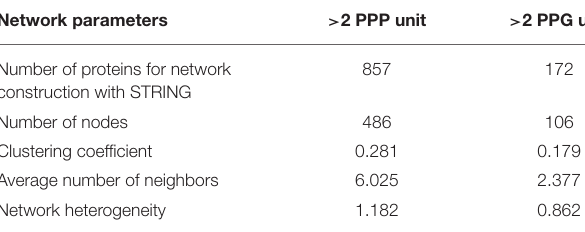
TABLE 2 | Protein network topology